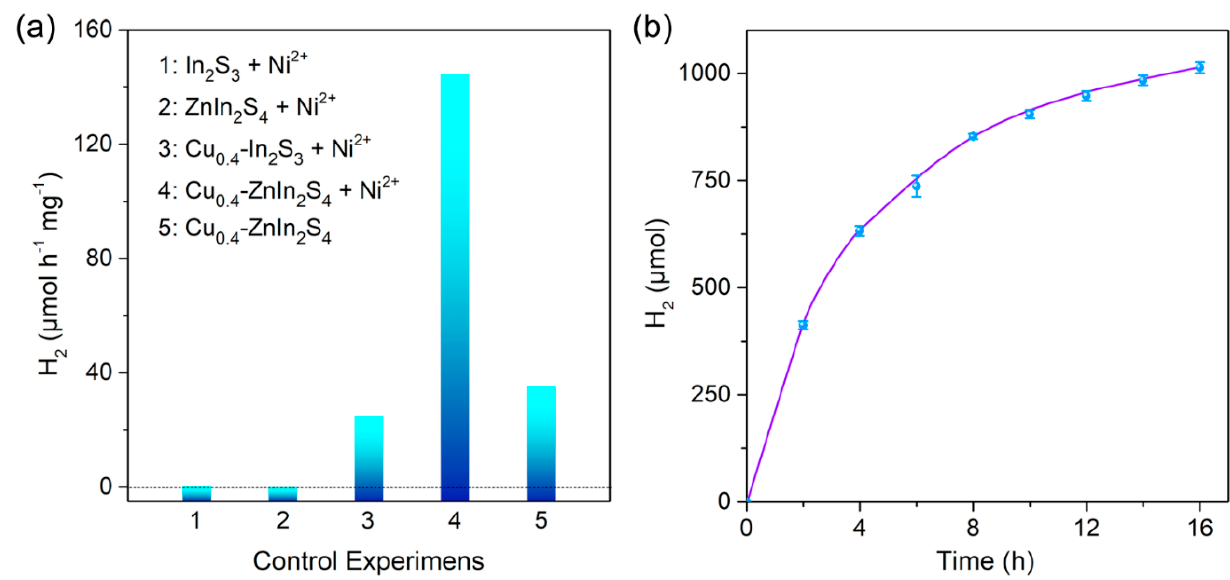
Figure 4. ( a ) Comparison of H 2 evolution of Cu 0.4 -ZnIn 2 S 4 QDs with In 2 S 3 , ZnIn 2 S 4 and Cu 0.4 -In 2 S 3 QDs under the in situ loaded Ni 2+ as cocatalysts, and photocatalytic activity comparison of Cu 0.4 -ZnIn 2 S 4 QDs with/without cocatalysts. ( b ) Long-time photocatalytic H 2 evolution of Cu 0.4 -ZnIn 2 S 4 QDs under optimal conditions. The photocatalytic reaction was performed with 1.6 mg of QDs, 10 µ g of nickel acetate tetrahydrate and 400 mg of ascorbic acid dispersed in 6.0 mL aqueous solution at pH 5.2, using 460 nm LEDs irradiation. Error bars represent the mean ± s.d. of multiple independent experiments.